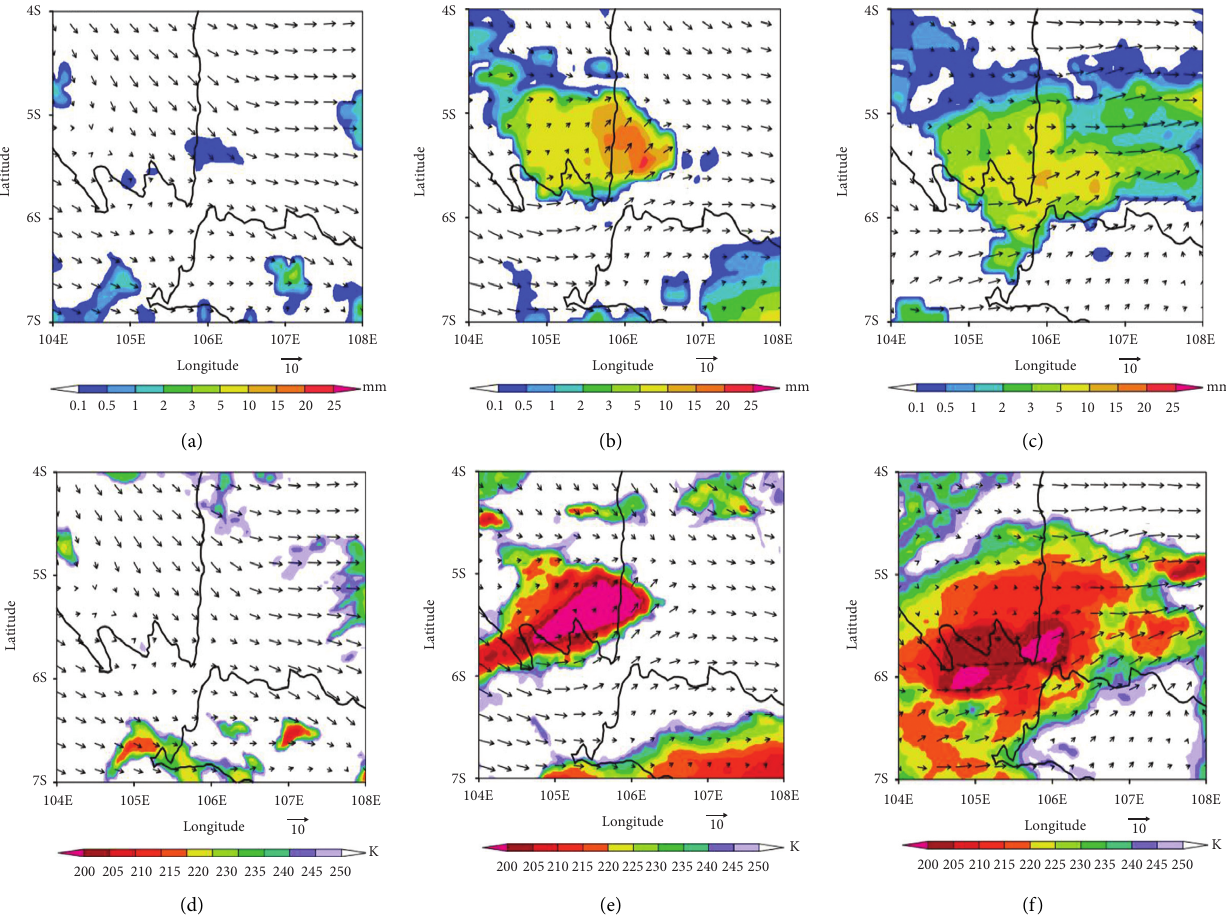
Figure 4: (a–c) evolution of observed rainfall and surface wind derived from GSMaP and CCMP data, respectively, during January 1-2, 2021, for (a) 13:00 LST; (b) 19:00 LST; (c) 01:00 LST. (d–f) same as the upper panel, but for temperature black body (TBB) of cloud from Himawari